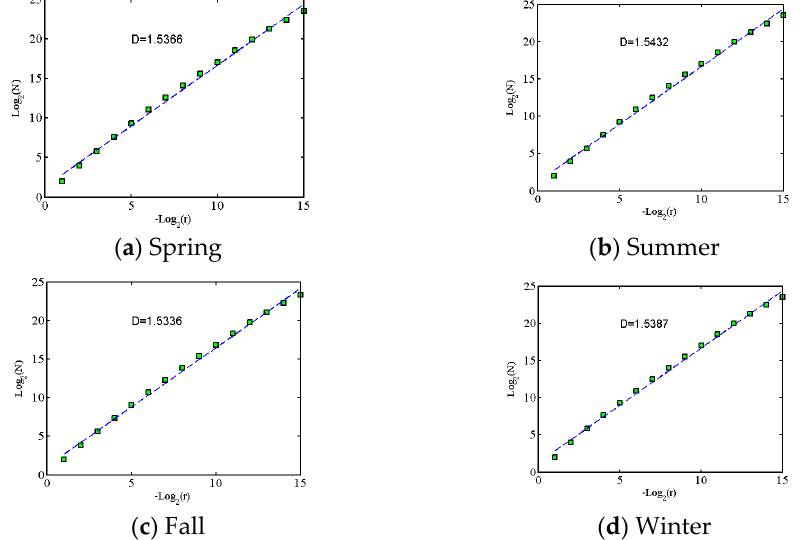
Figure 2. Fractal dimension of seasonal wind speed (( a ): Spring; ( b ): Summer; ( c ): Fall; ( d ): Winter).